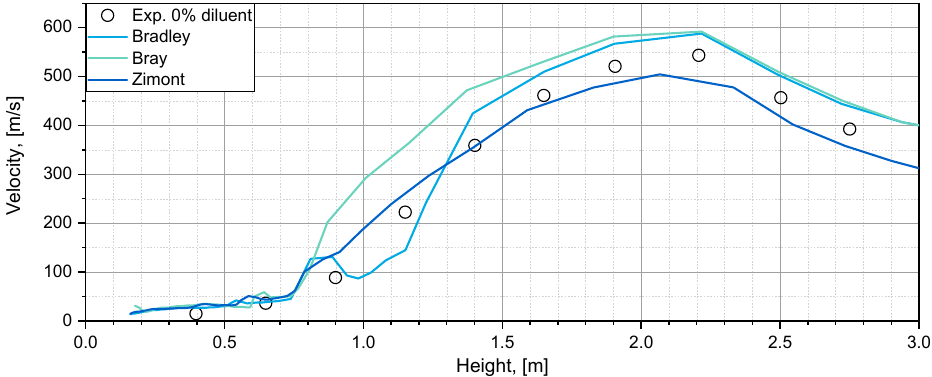
Figure 7. Comparison of velocity profiles obtained with different turbulent combustion correlations (k- ε case).